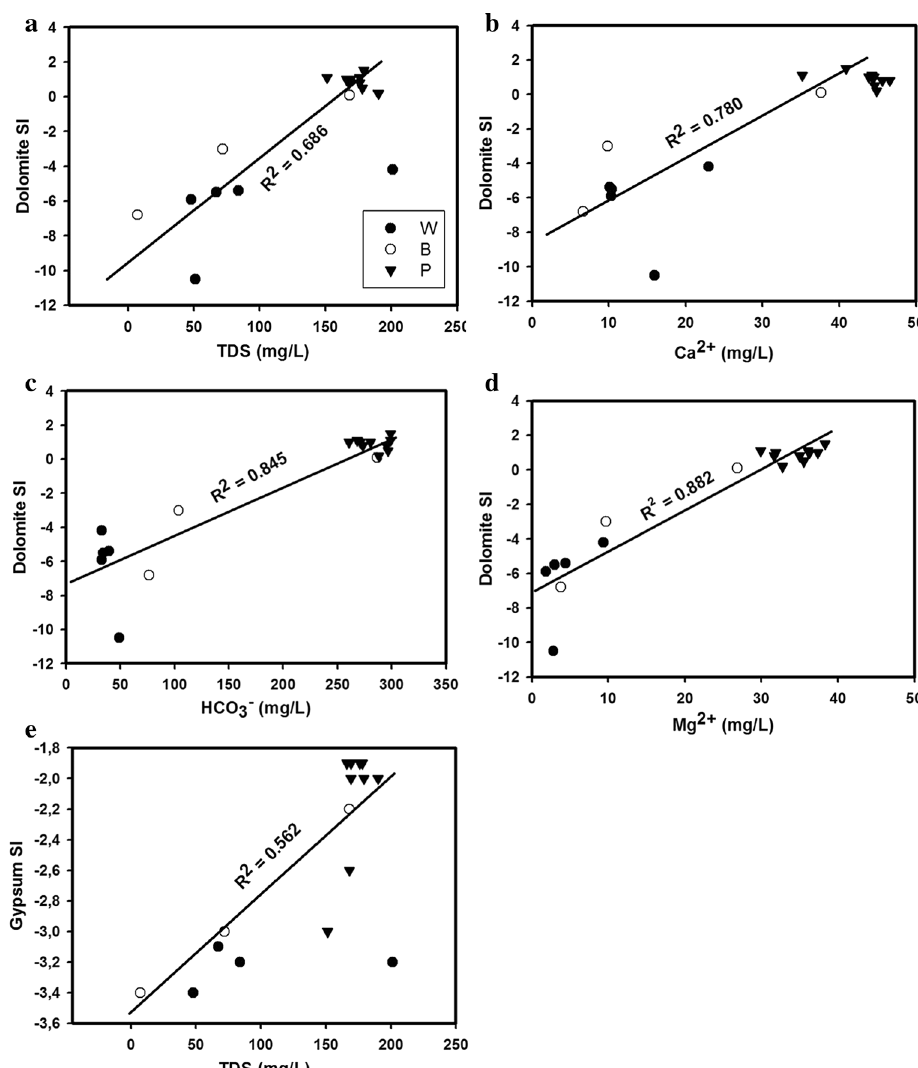
Fig. 7 a Relationship of TDS to dolomite saturation indices; b relationship of Ca 2+ to dolomite saturation indices; c , d relation- ships of HCO 3− and Mg 2+ to dolomite saturation indices; e relationship of TDS to gypsum saturation